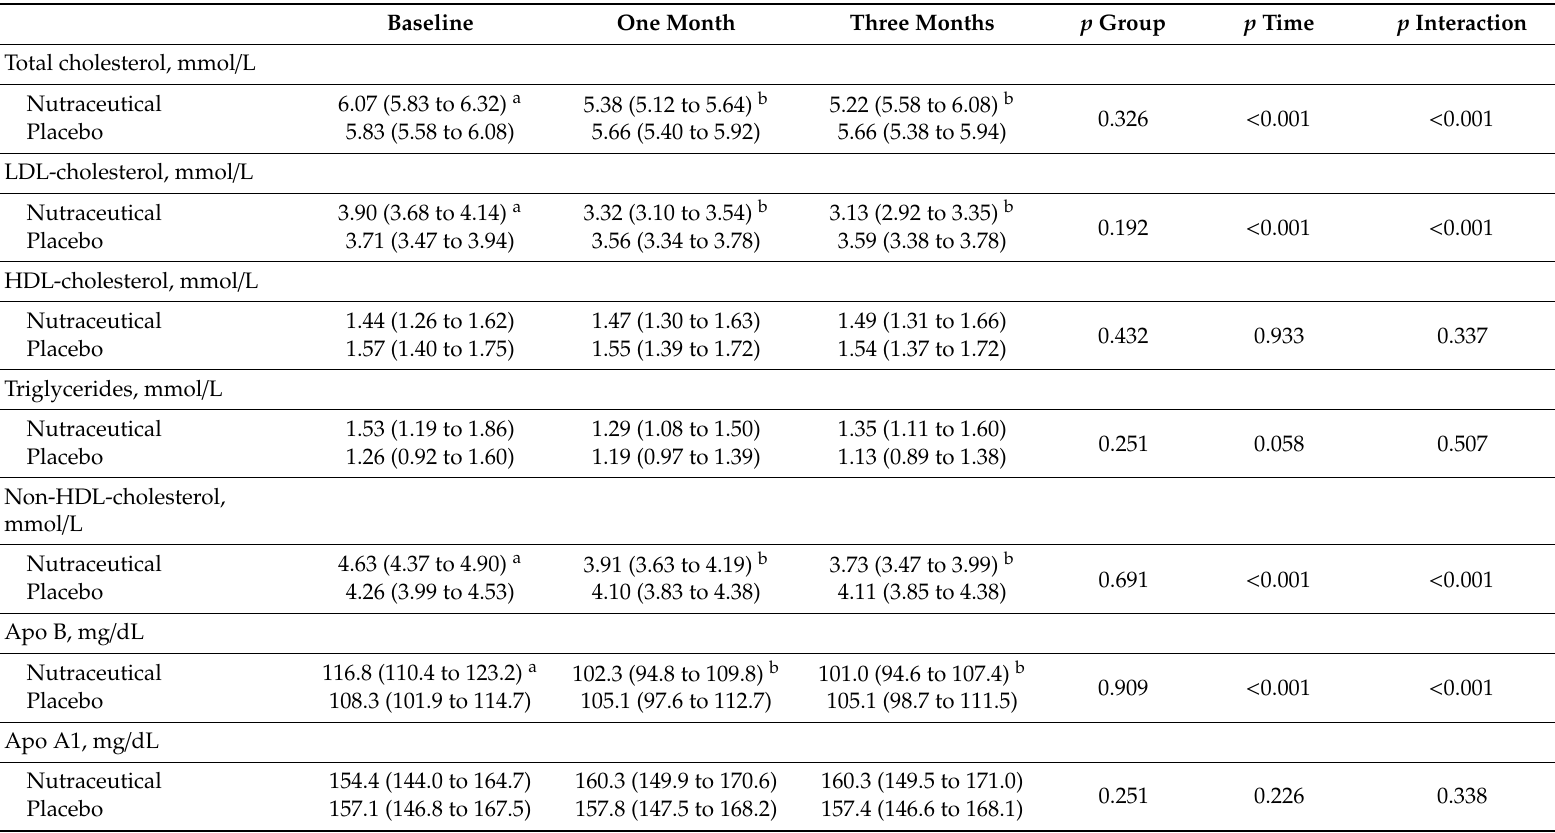
Table 3. Baseline and final values of lipids and apolipoproteins by group